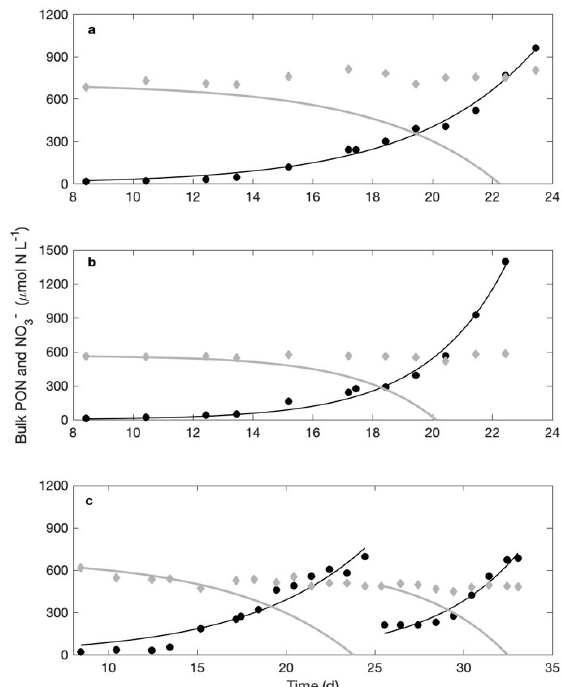
Figure 2. Experiment 3-1. Measured (closed, black circles) and fitted (black line) biomass dynamics expressed as particulate organic nitrogen (PON, µ mol N L − 1 ) and measured NO 3 − concentration (grey, closed diamonds) in the three culture replicates ( a – c ) of the NO 3 − -rich cultures. The grey line is the predicted changes in NO 3 − concentration that would be observed should nitrate uptake support 100% of the biomass formed during the experiment.